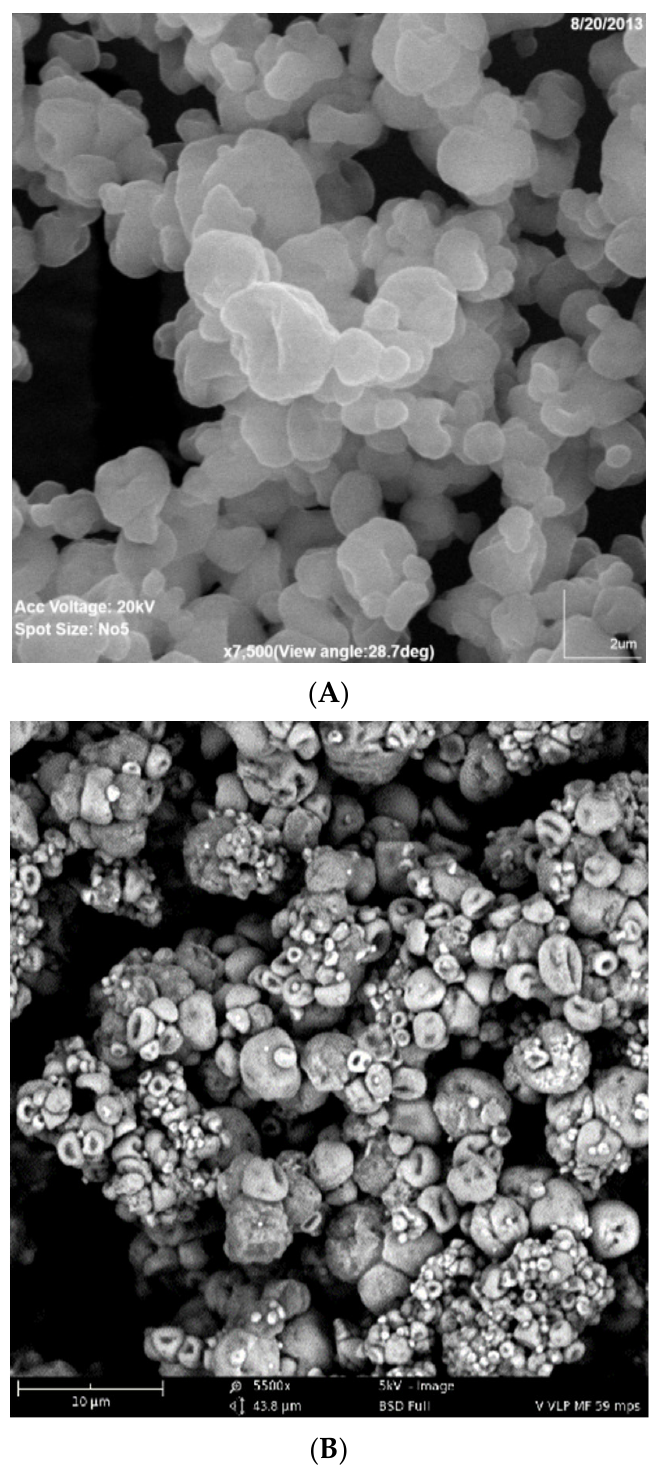
Figure 2. ( A , B ). Scanning Electron Microscope Image of Formulations 1 and 2. ( A ) Formulation 1 (HPV16VLP MPs). ( B ) Formulation 2 (HPV16VLP-MPL-alum-MPs).